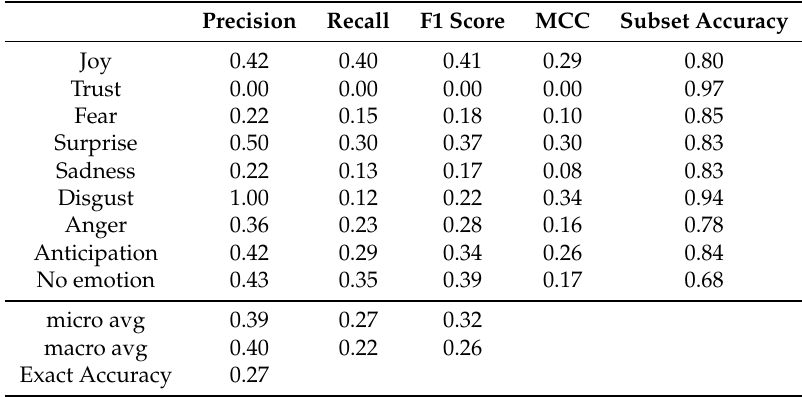
Table 12. Feed-forward neural network.